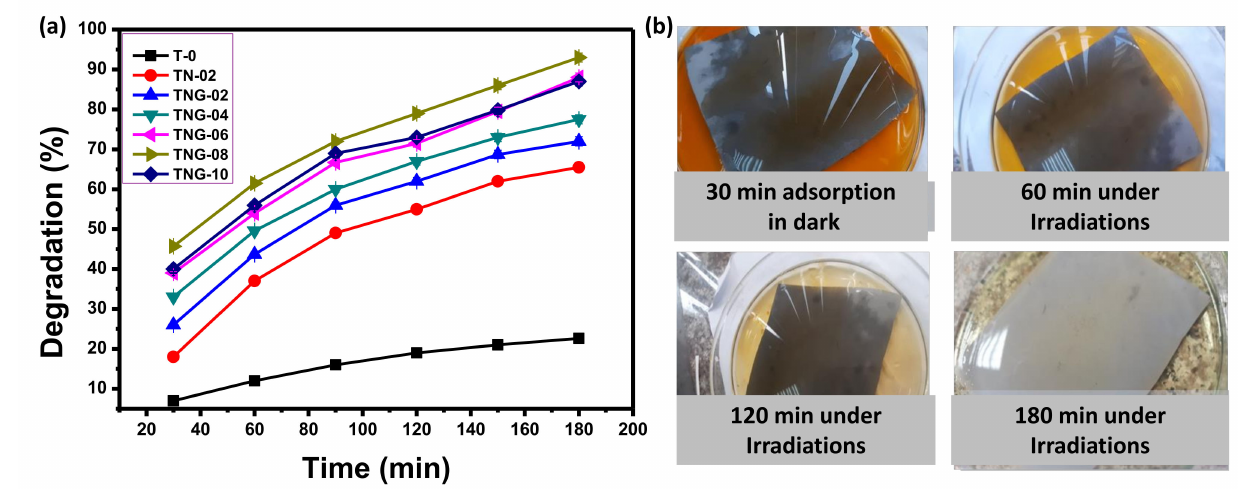
Figure 7. Effect of reaction time on photocatalytic degradation of MO ( a ) Using TPU and its composite membranes with NiO/NH 2 -GO (reaction conditions pH = 4, MO = 25 ppm, membrane area = 50 cm 2 , light source = UV 254 nm, and H 2 O 2 = 10 mM), ( b ) visual description of TNG-08 working under optimized conditions.